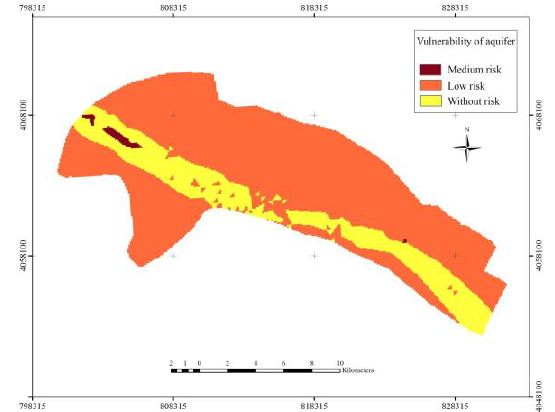
Figure 10. The vulnerability map of aquifer in the study area (Parizangeneh et al. 2014)